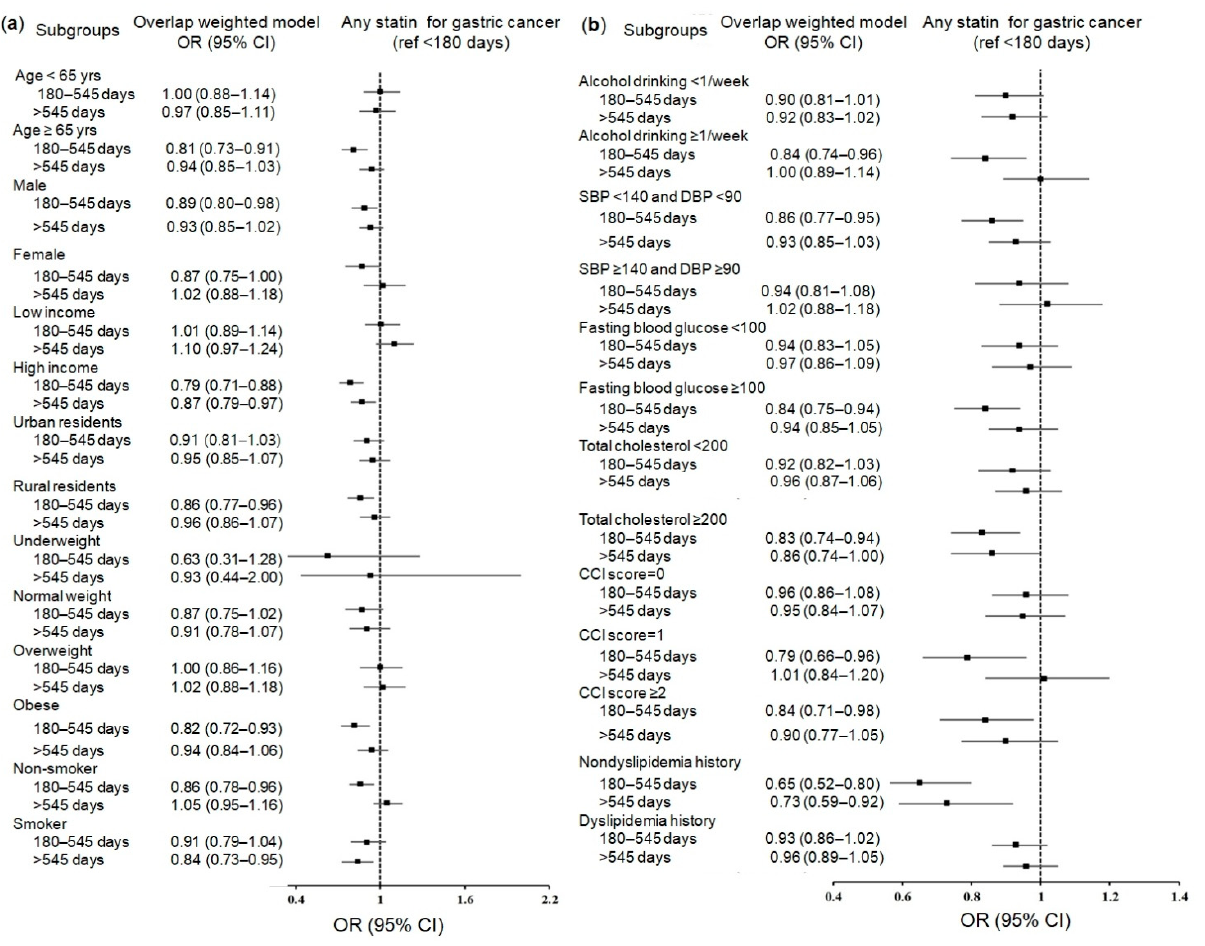
Figure 1. Forest plots for multivariable conditional logistic regression depicting the overlap weighted odds ratios (95% confidence intervals) of previous use duration of any statin for incident gastric cancer according to comprehensive subgroup analyses, including age, sex, income, region of residence, obesity, and smoking ( a ), alcohol consumption, systolic blood pressure, diastolic blood pressure, fasting blood glucose, total cholesterol, CCI scores, and dyslipidemia history ( b ). The reference period is <180 days. Full results of the crude and adjusted overall weighted models are available in Supplementary Table S1 (any statin).